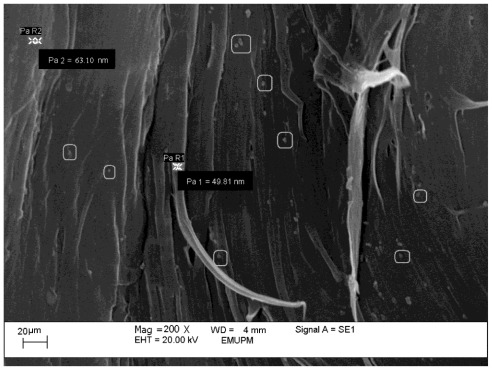
SEM micrograph of PCL/chitosan/1 wt% CaCO3 nanoparticles.